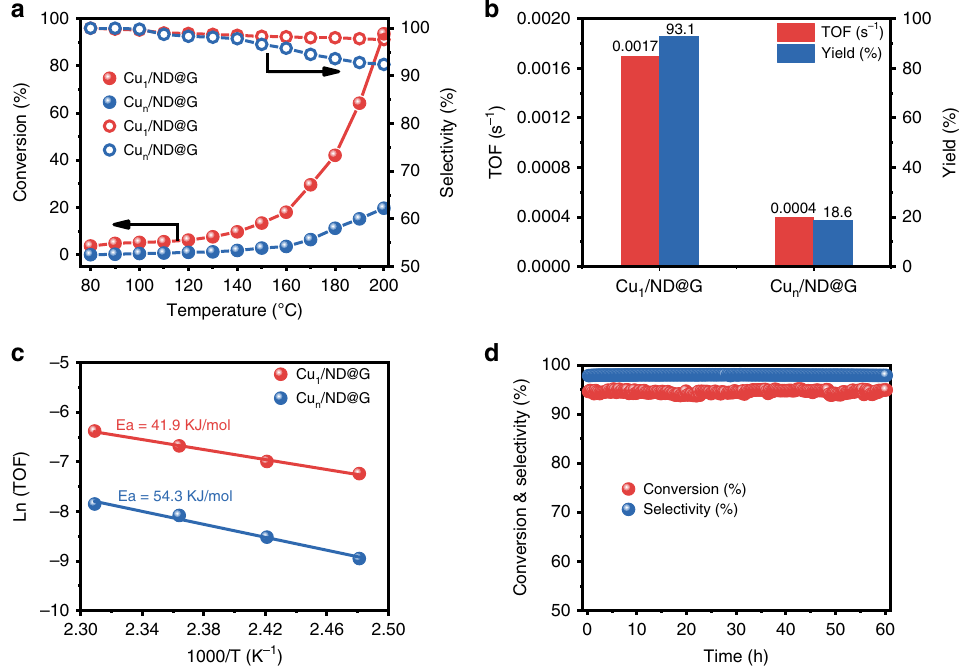
Fig. 4 Catalytic performance of Cu 1 /ND@G and Cu n /ND@G. a Conversion and selectivity as a function of temperature for the selective hydrogenation of acetylene over the Cu 1 /ND@G and Cu n /ND@G catalysts. b TOF values (in the kinetic region) and ethylene yields ( T = 200 °C) of the catalysts. c Arrhenius plots of the catalysts. d Durability test on Cu 1 /ND@G at 200 °C for 60 h. (reaction condition: 1% C 2 H 2 , 10% H 2 , 20% C 2 H 4 gas mix balanced with He; GHSV = 3000 h − 1